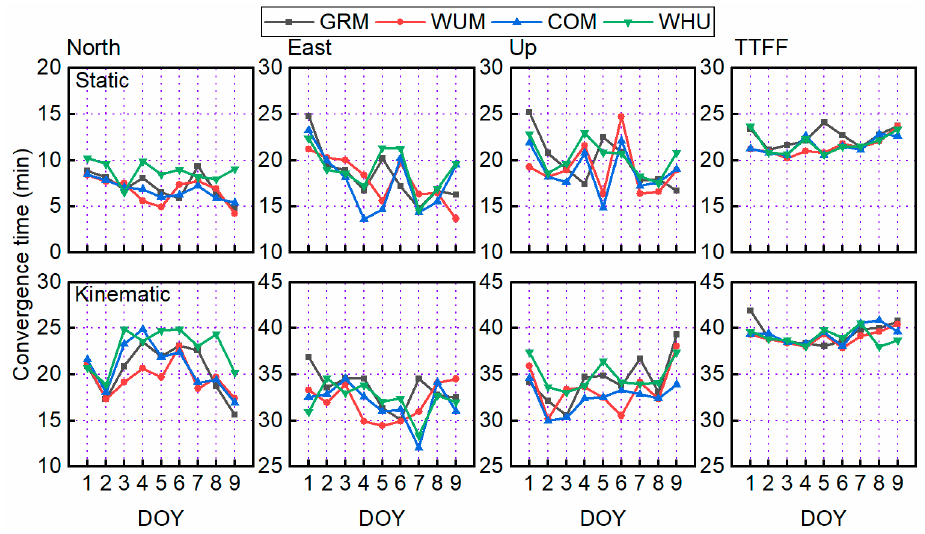
Figure 6. Average convergence time series among nine days of static (top) and kinematic (bottom) GPS-only PPP AR in north, east, up, and 3D components with GRM, WUM, COM, and WHU products.